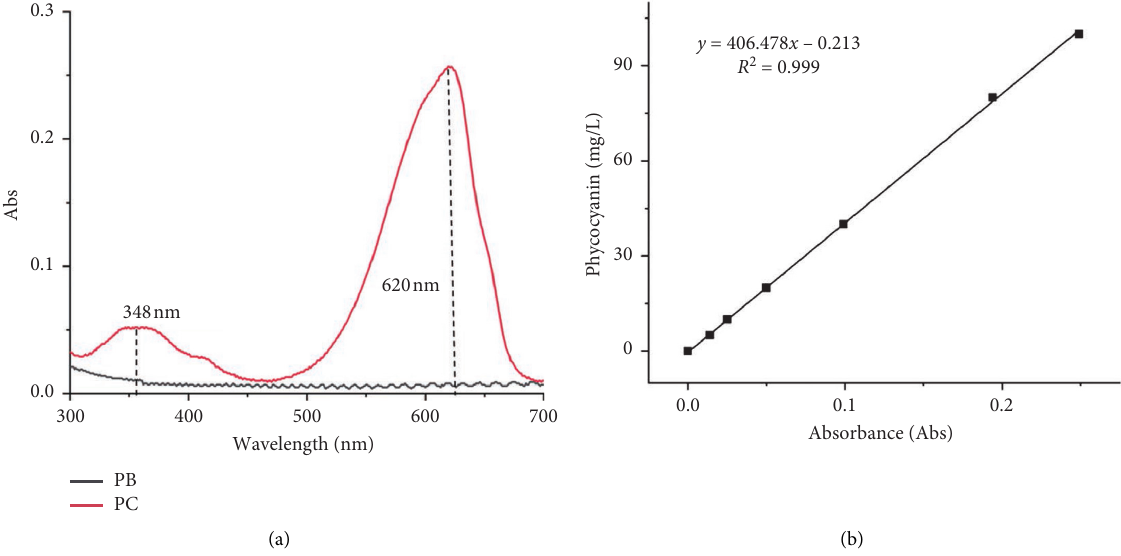
Figure 2: (a) Absorbance spectrum of phycocyanin (PC) standard solution and its solvent (PB); (b) standard curve for the absorbance of